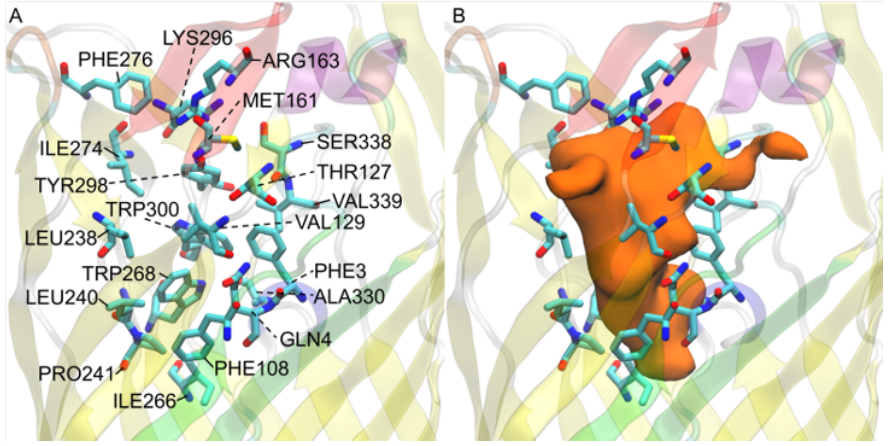
Figure 10. V. cholerae vc1043 FA interacting residues: ( A ) residue names and locations; ( B ) predicted transport channel shown from a surface view of all docked FAs (orange) shown with its relation to the displayed residues. The L3 loops is colored red, the L4 loop is colored orange, and the S3 kink is colored green for